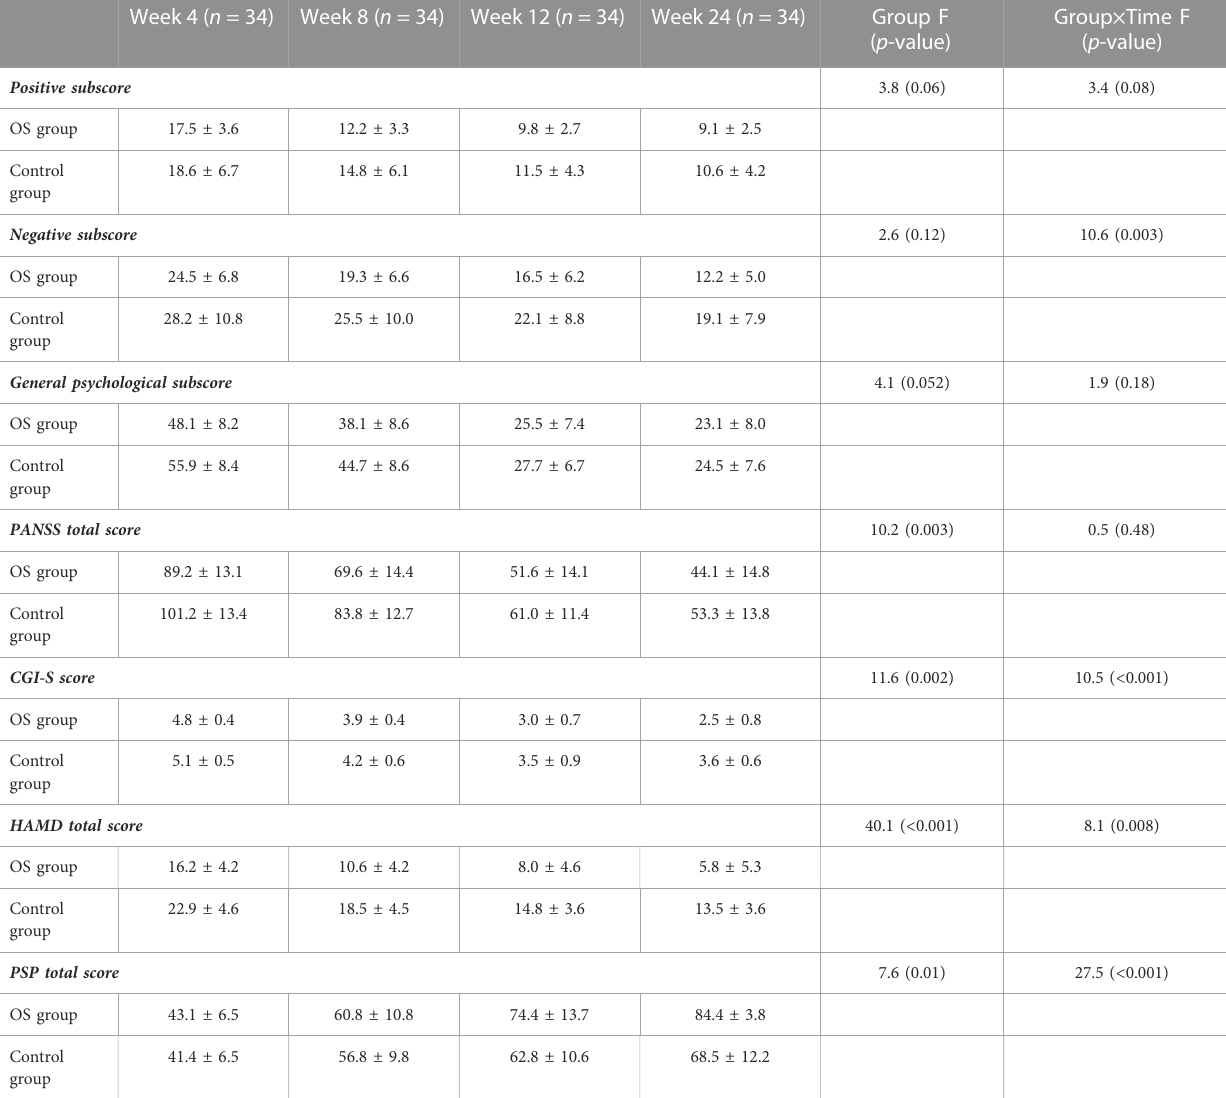
TABLE 2 PANSS scores, HAMD score, CGI-S, and PSP at baseline, weeks 4, 8, 12, and 24 in the patients treated with olanzapine plus sertraline (OS) group and olanzapine monotherapy (control) group (mean ± standard